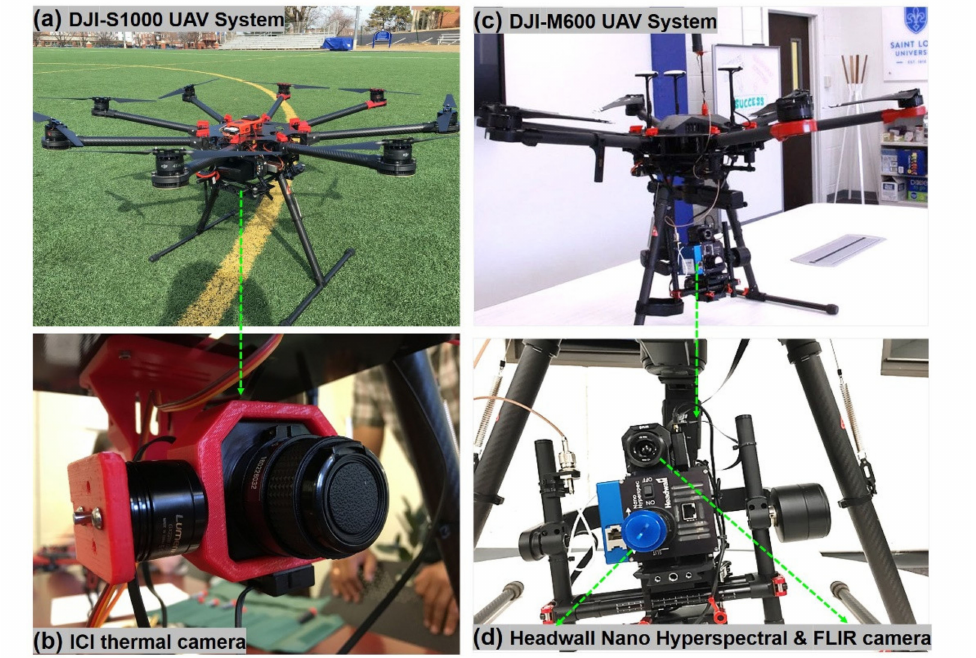
Figure 2. UAV systems and interrelated sensors. DJI S1000 + UAV system ( a ) with ICI thermal camera ( b ), DJI-Matrice 600 Pro UAV system, ( c ) with Headwall Nano Hyperspectral and FLIR thermal cameras ( d